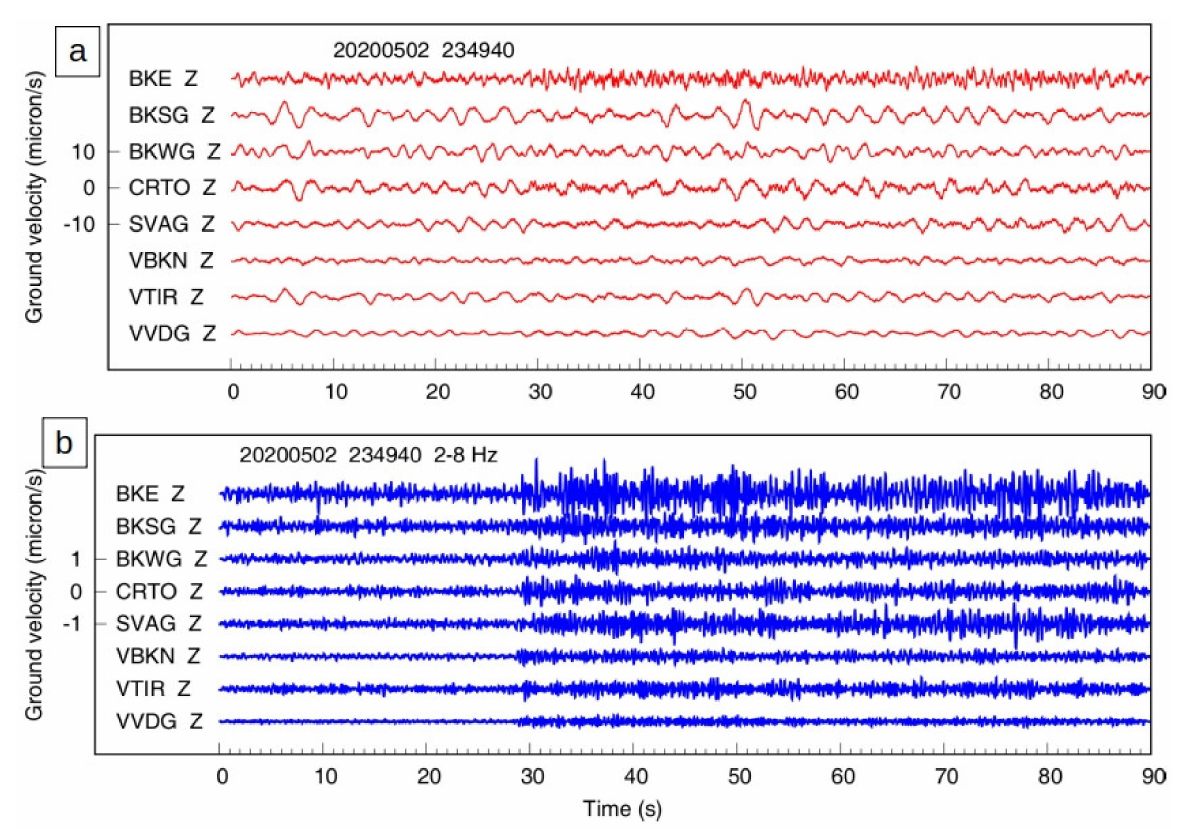
Figure 7. ( a ) Seismic waveforms (vertical components in red lines, no filtered data) recorded from eight seismic stations installed at the top of the volcano (Figure 1). At first sight, these seismograms show only seismic noise. ( b ) The same seismograms after filtering in the 2–8 Hz frequency band (in blue lines) show a very small amplitude signal with onset just before 30 s, visible at all stations of the monitoring